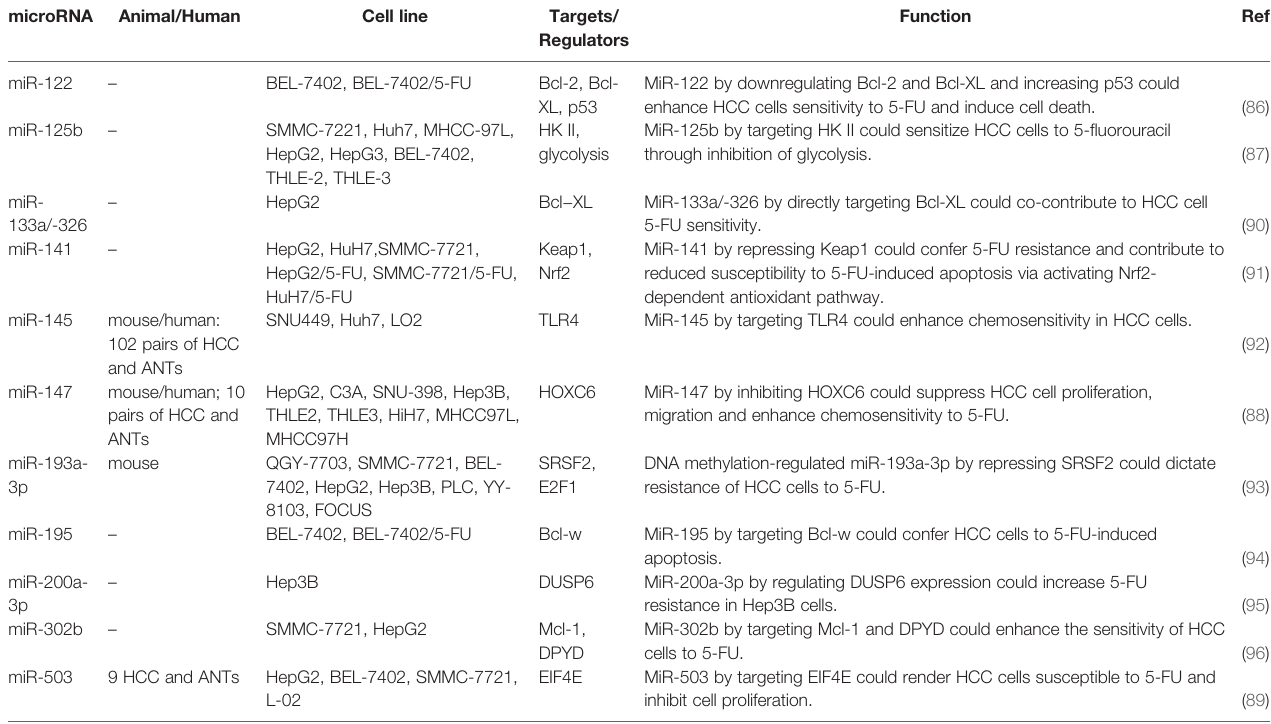
TABLE 2 | Role of miRNAs in the modulation of response to 5-FU in hepatocellular carcinoma (ANT, adjacent normal tissue). microRNA